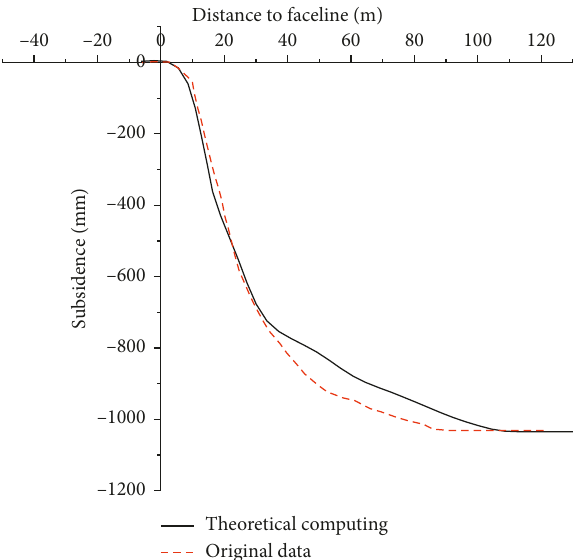
Figure 15: Subsidence of the field measurements and the theo- retical calculations of the voussoir beam